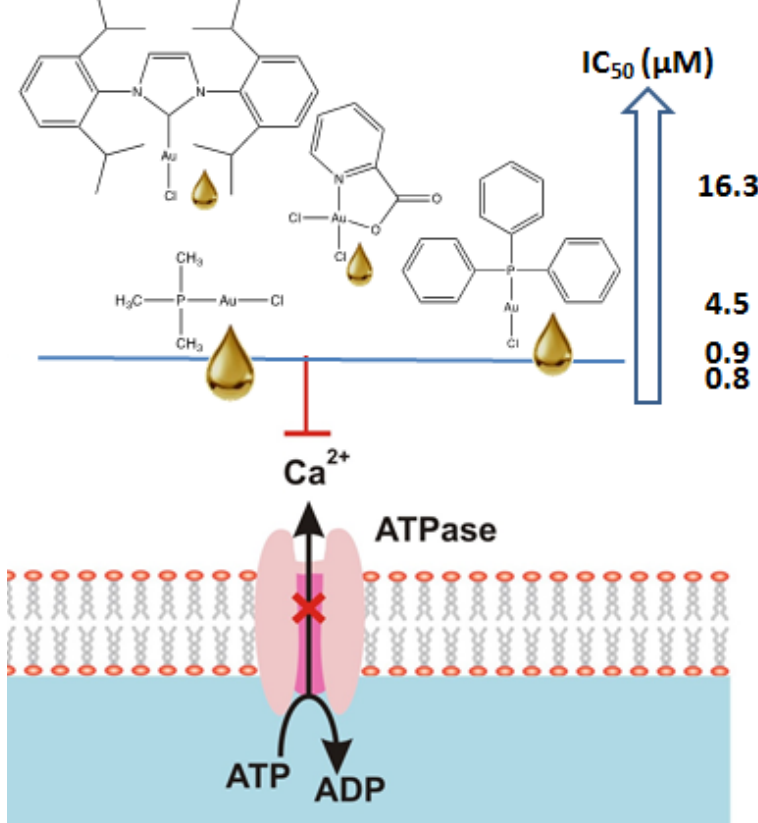
Figure 6. Gold compounds interacting with P-type ATPases, a putative target for gold anticancer activities.